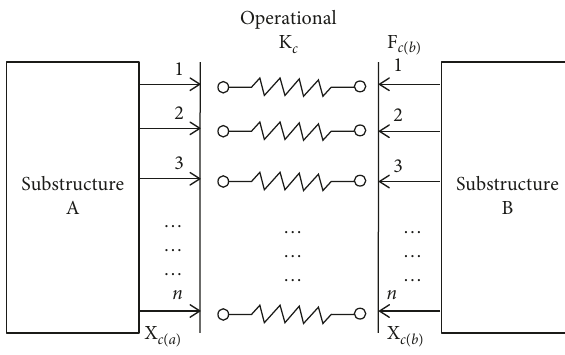
Figure 3: Two subsystems with n -connection coupled